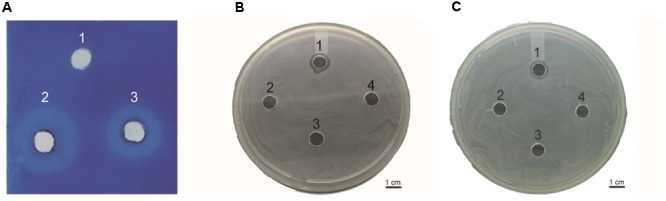
(A) Detection of peptidoglycan degradation by endolysin Ply6A3 by diffusion method. Hole 1: 20 μl PBS, Hole 2: 20 μl Lysozyme (2 mg/ml), Hole 3: 20 μl endolysin (2 mg/ml). (B) Lytic activity of endolysin against clinical AB32 isolates. (C) Lytic activity of endolysin Ply6A3 against clinical MRSA6 isolates. Hole 1: 20 μl endolysin (2 mg/ml), Hole 2: 20 μl Phage PD6A3 (108cuf/ml), Hole 3: 20 μl Phage Cocktail (108cuf/ml) Hole 4: 20 μl PBS. Scale bar, 1 cm. CFU, colony-forming units. PD6A3, a novel Acinetobacter baumannii Phage. Ply6A3, the endolysin encoded by a novel Acinetobacter baumannii Phage PD6A3 gene. AB32, the No. 32 strains of Multidrug Resistance Acinetobacter baumannii. MRSA6, the No. 6 strains of methicillin-resistant Staphylococcus aureus.